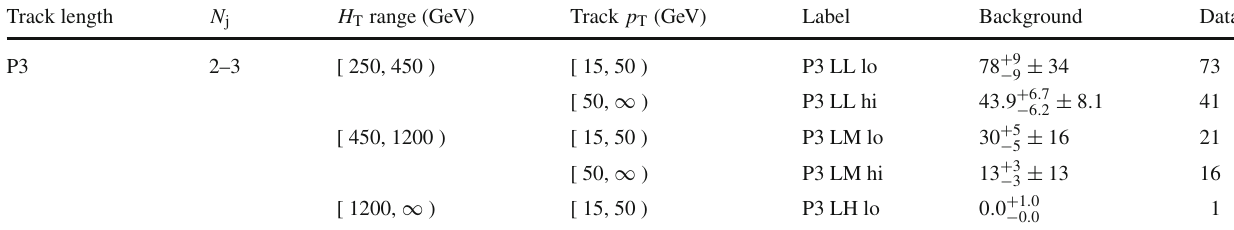
Table 25 Summary of the 24 signal regions of the search for disap- pearing tracks for pixel tracks, for the 2017–2018 data set, together with the corresponding background predictions and observations.